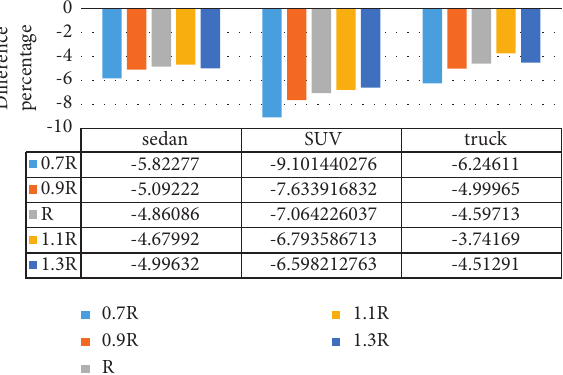
Figure 21: Difference percentage between the maximum yaw rates in the simple and spiral horizontal curves with respect to the simple horizontal curves for the speed of 100km/h.